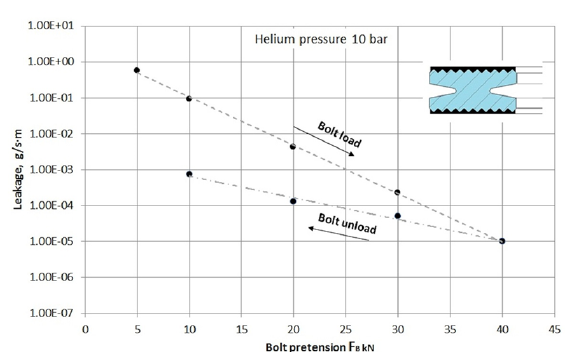
Figure 7: Leakage characteristic in load and unload state of the bolt in case of the joint gasketed with the symmetrically grooved